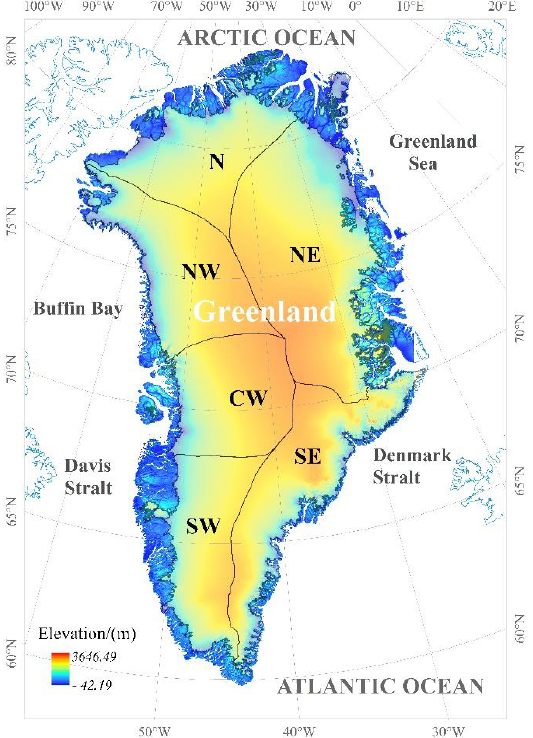
Figure 1. Greenland regions superimposed on the elevation map.